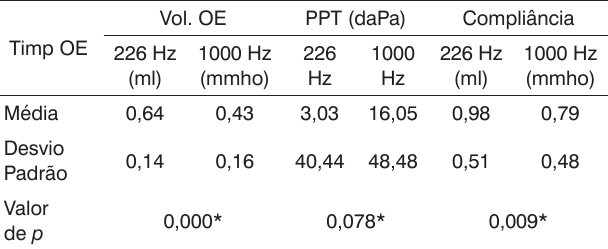
Tabela 2. Medidas dos valores da timpanometria com sonda de 226 Hz e 1000 Hz na OE.